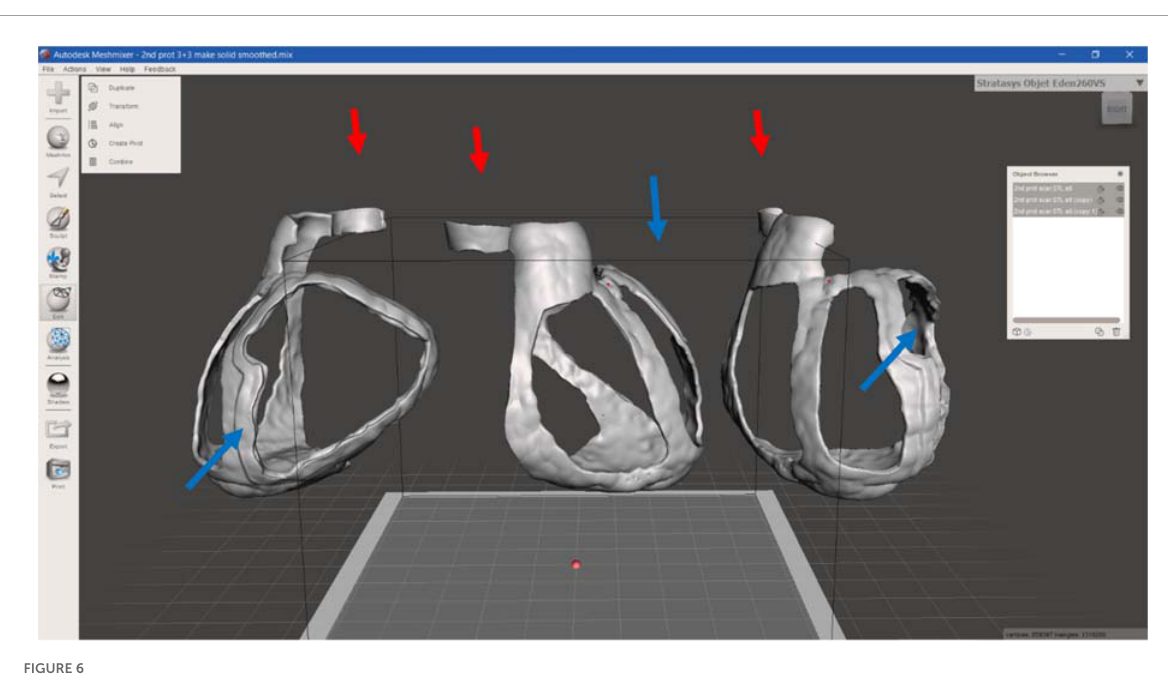
Stratasys Objet260 Connex1 is a Polyjet 3D printing, an additive manufacturing process in which layers of polymeric materials are jetted at specific position onto a build tray and the UV lamps, mounted on the print block, partially drying